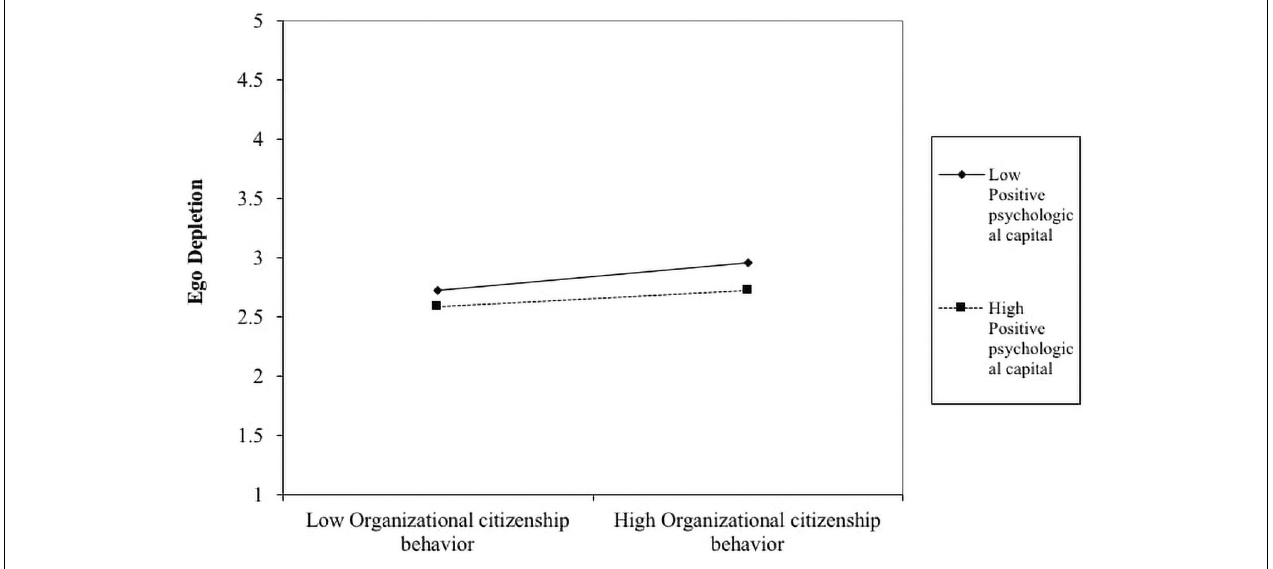
FIGURE 3 | The interactive effect of OCB and Positive PsyCap on ego depletion. TABLE 4 | Results of the conditional direct and indirect effects of OCB on service sabotage via ego depletion at values of PsyCap. Predictor Mediator